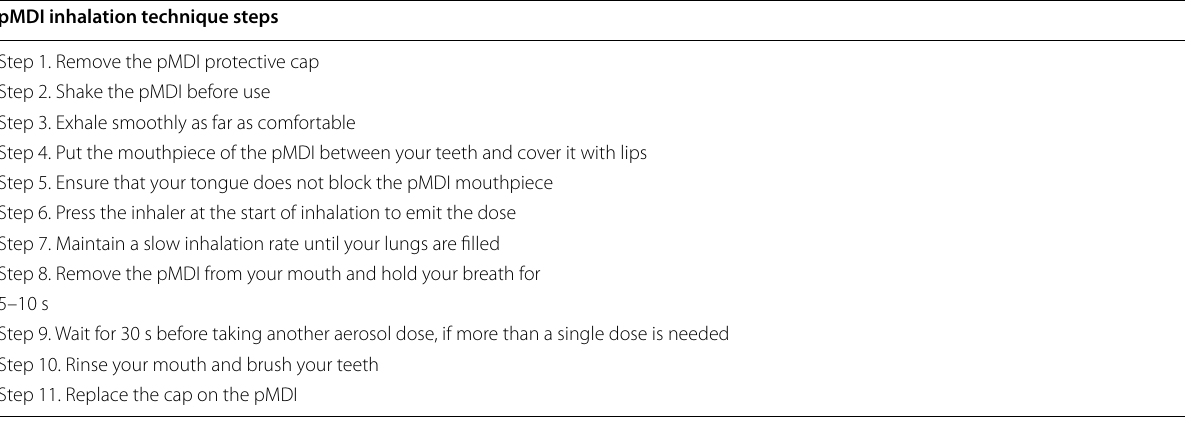
Table 1 Steps of correct pMDI inhalation technique pMDI inhalation technique